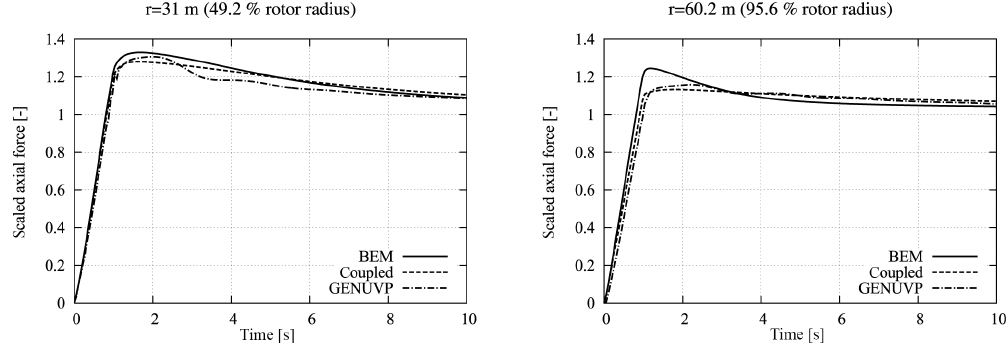
Figure 13. Scaled axial force at different radial positions during and after a pitch step by 5 ◦ in 1s.